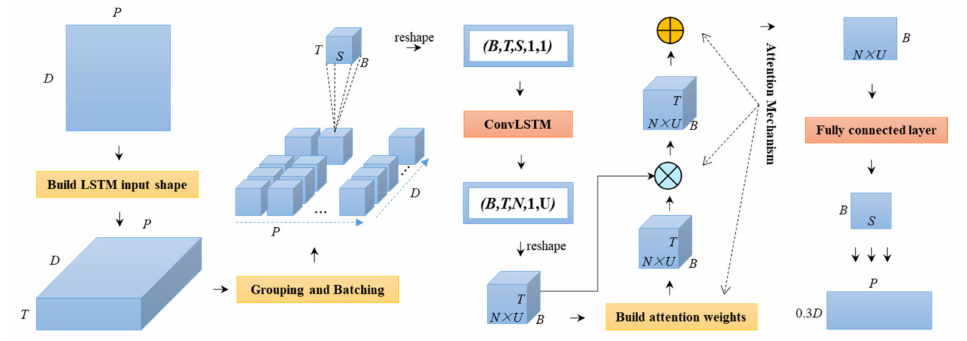
Figure 2. The structure of the